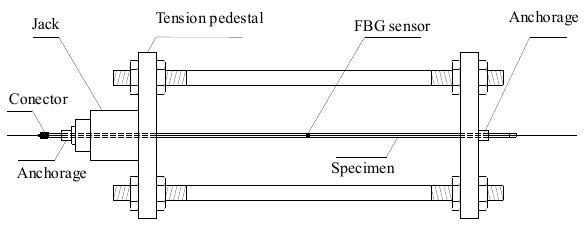
Fig. 4 Schematic diagram of the tensioning pedestal.